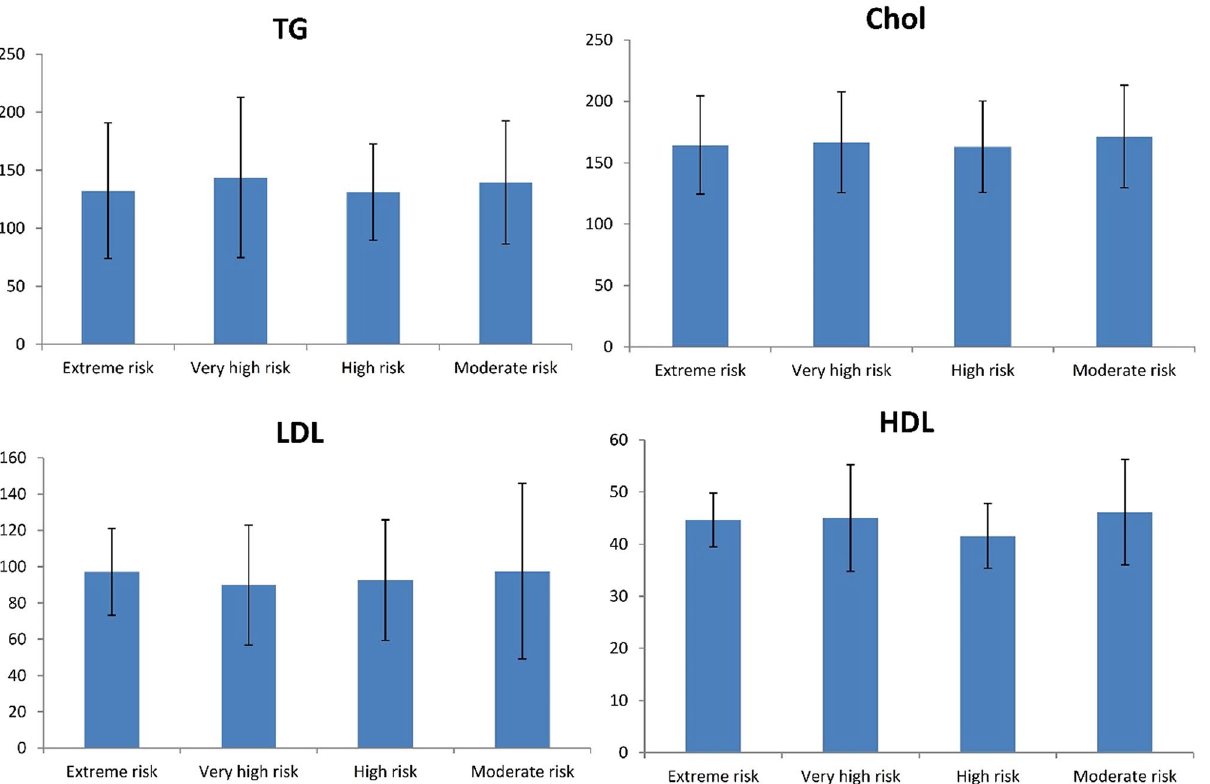
Figure 1. The value of lipid profile comparatively is drawn between the different ASCVD risk level category groups.